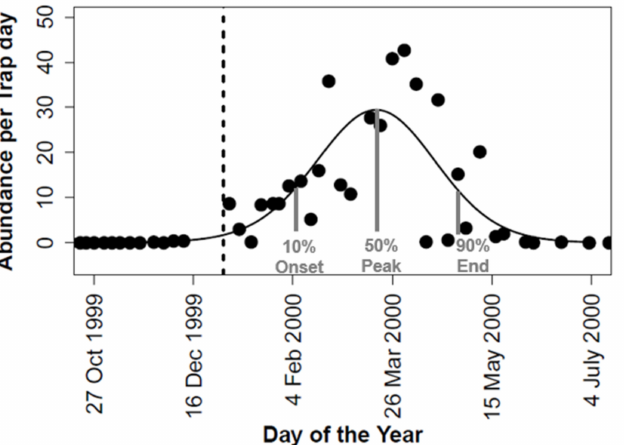
Figure 1. Example of fitting of a phenological curve using generalised additive models for abundance data of adults of the blowfly Calliphora vicina to estimate onset, peak, and end of emergence. This example is based on data for abundance per trap day for C. vicina collected in the years 1999–2000. The dashed vertical line indicates the start of the calendar